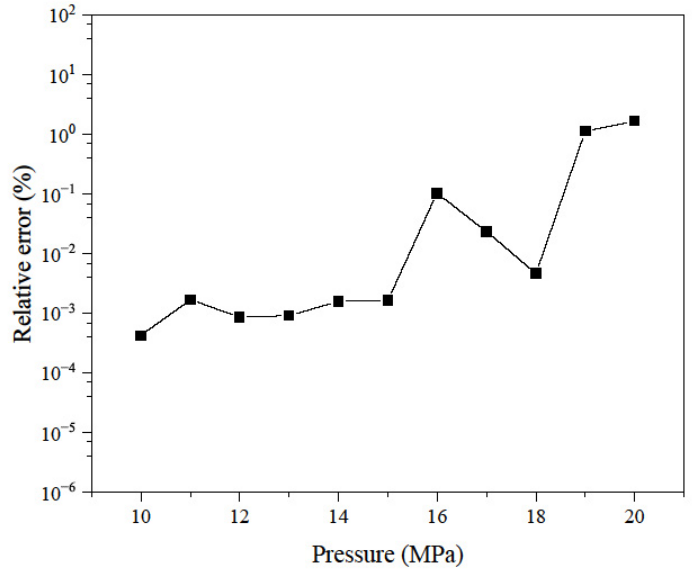
Figure 4. Relative error in T s with different pressure.